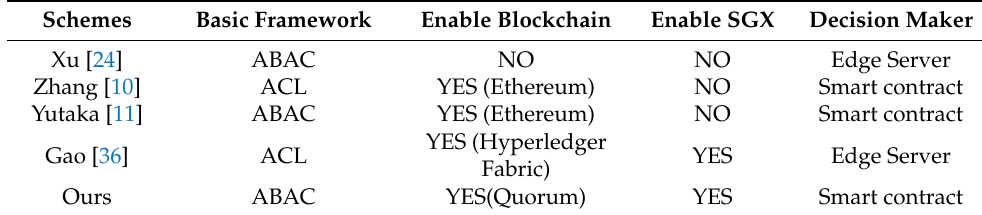
Table 1. Comparison of Internet of Things access control